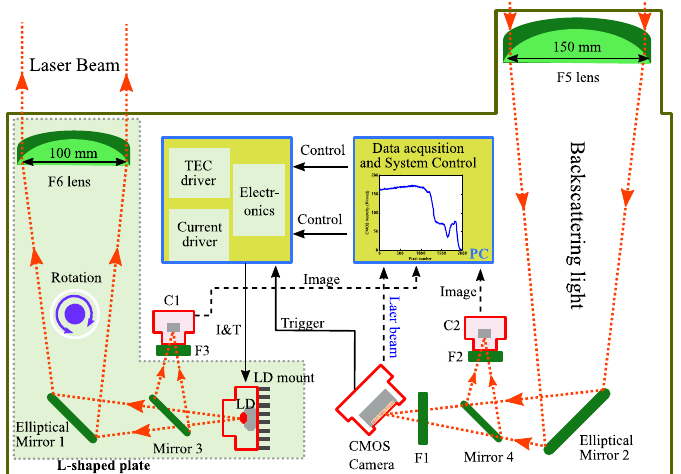
Figure 1. Schematic of the lidar system, LD: laser diode, F1 consists of an 808 nm interference filter and a RG715 long pass filter, F2: RG780 long pass filter, F3: RG780 long pass filter, Mirror 3 and Mirror 4: 10% reflection and 90% transmission mirrors, C1 and C2 are black-white cameras.